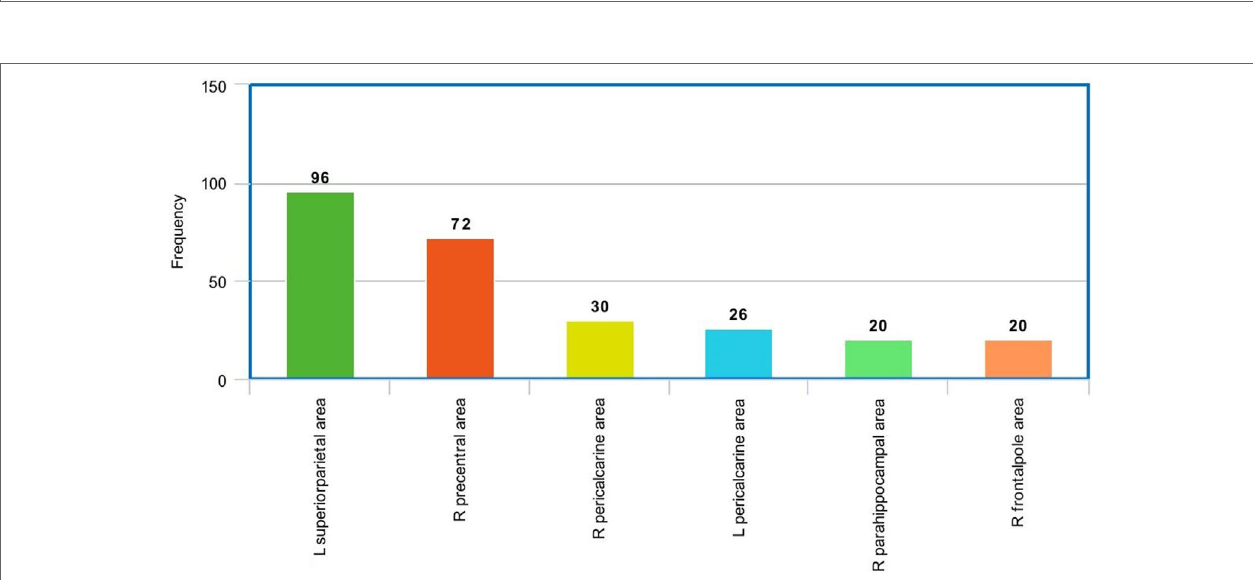
FIGURE 8 | The most frequent areas in the fMRI experiment found to be associated with significantly correlated features with ADOS overall score.